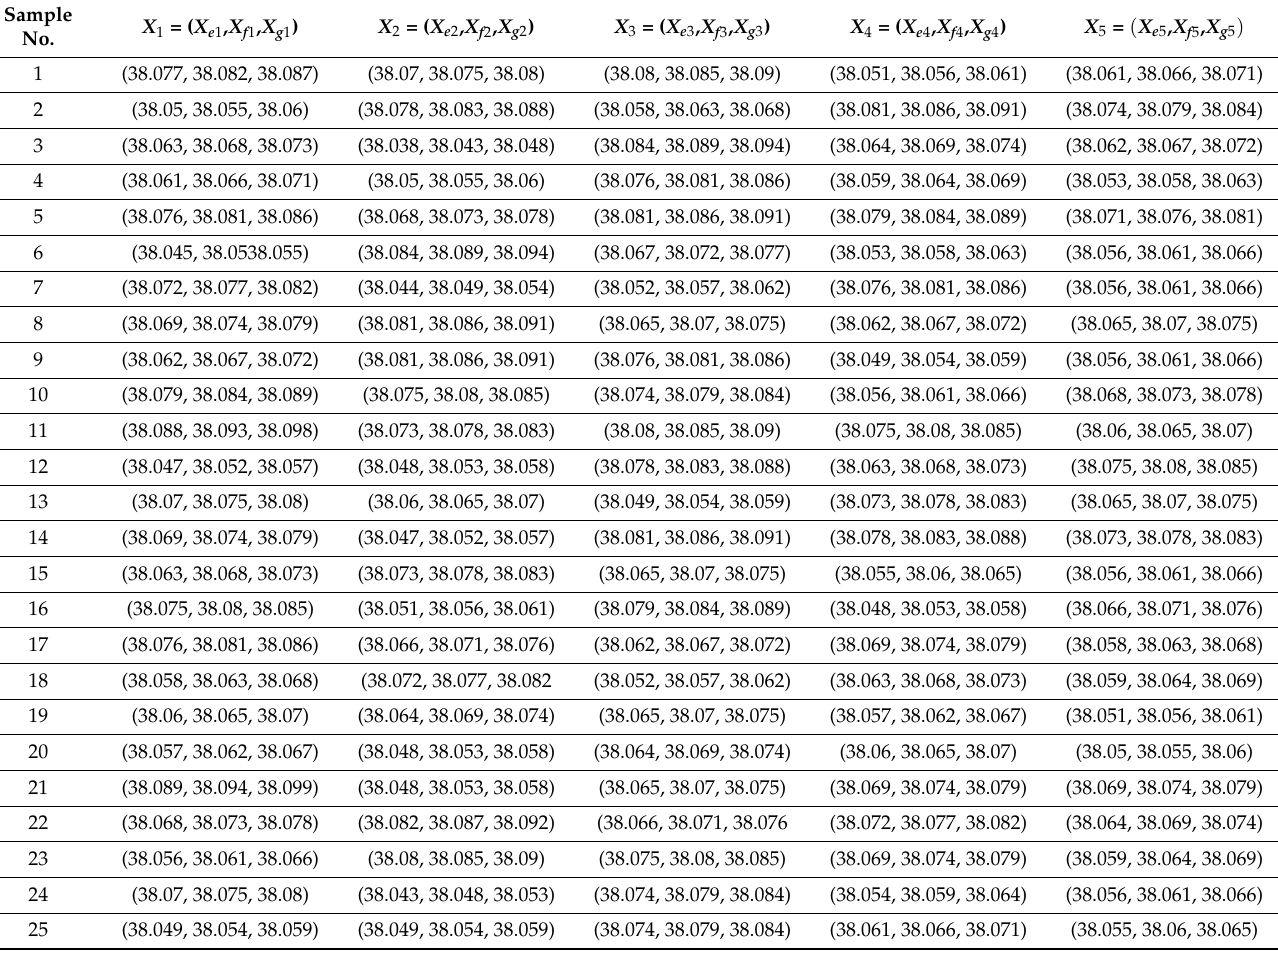
Table 1. The inside diameter (in mm) of power loom change gear in fuzzy environment.